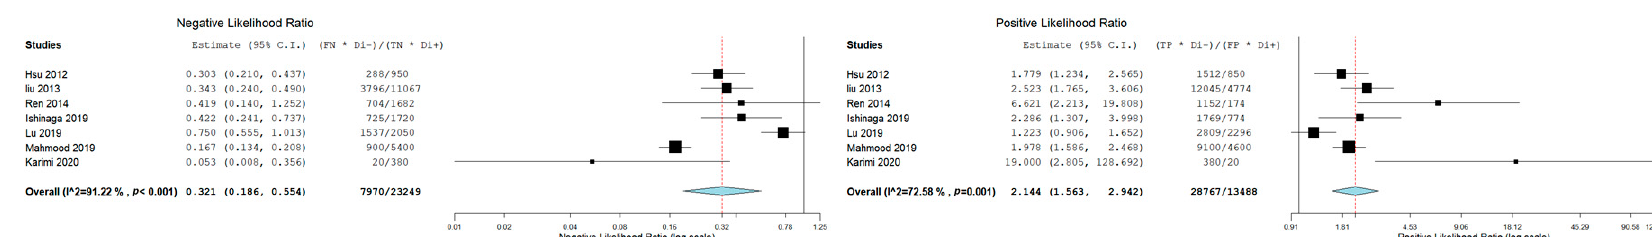
Figure 3. Forest plot of the sensitivity and specificity.